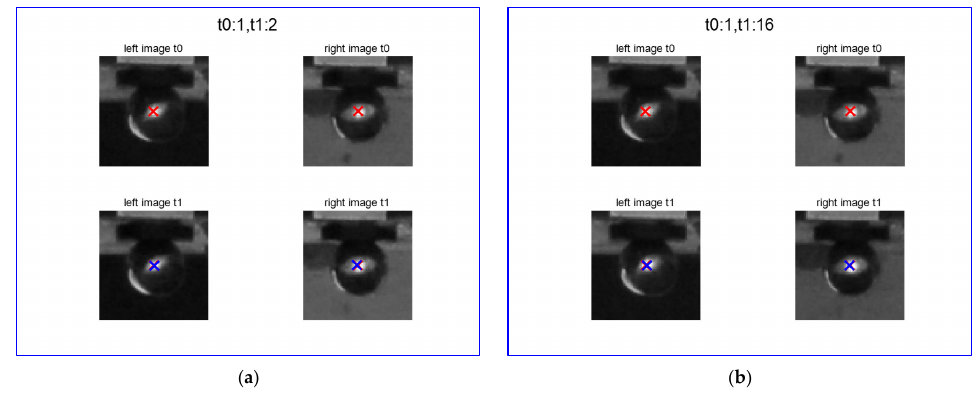
Figure 7. Target matching results using the correlation ‐ coefficient and the least ‐ squares techniques. ( a ) Matched points of the second images from the first images; ( b ) matched points of the 16th images from the first images.